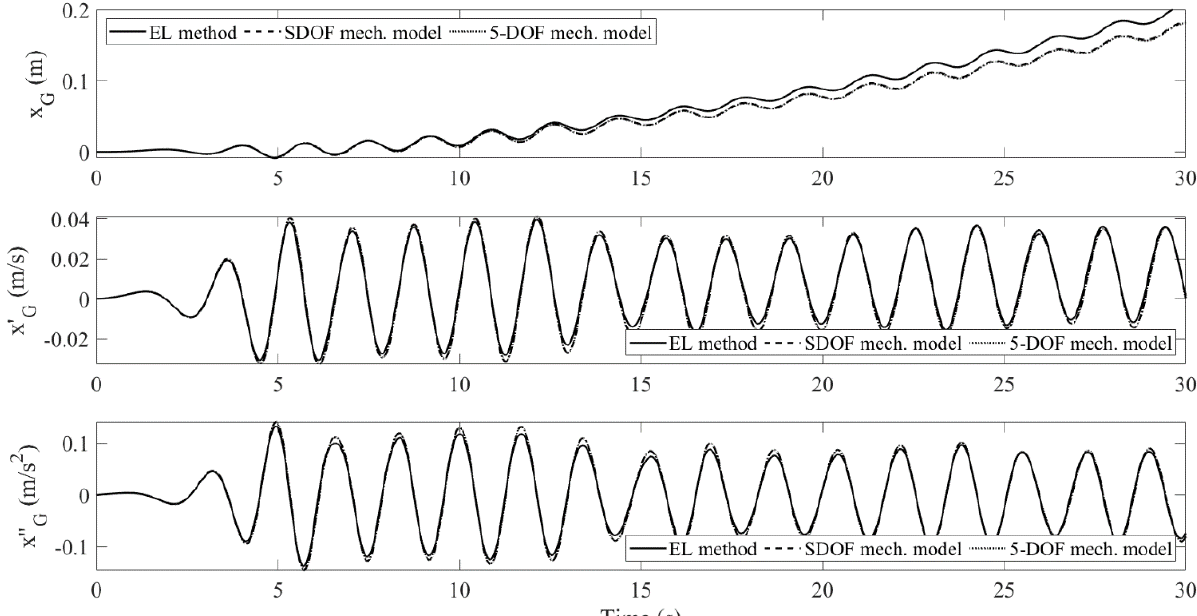
Figure 14. The surge motion responses of the floating body, configured with a water tank installed with porous media, undergoing small wave excitation.